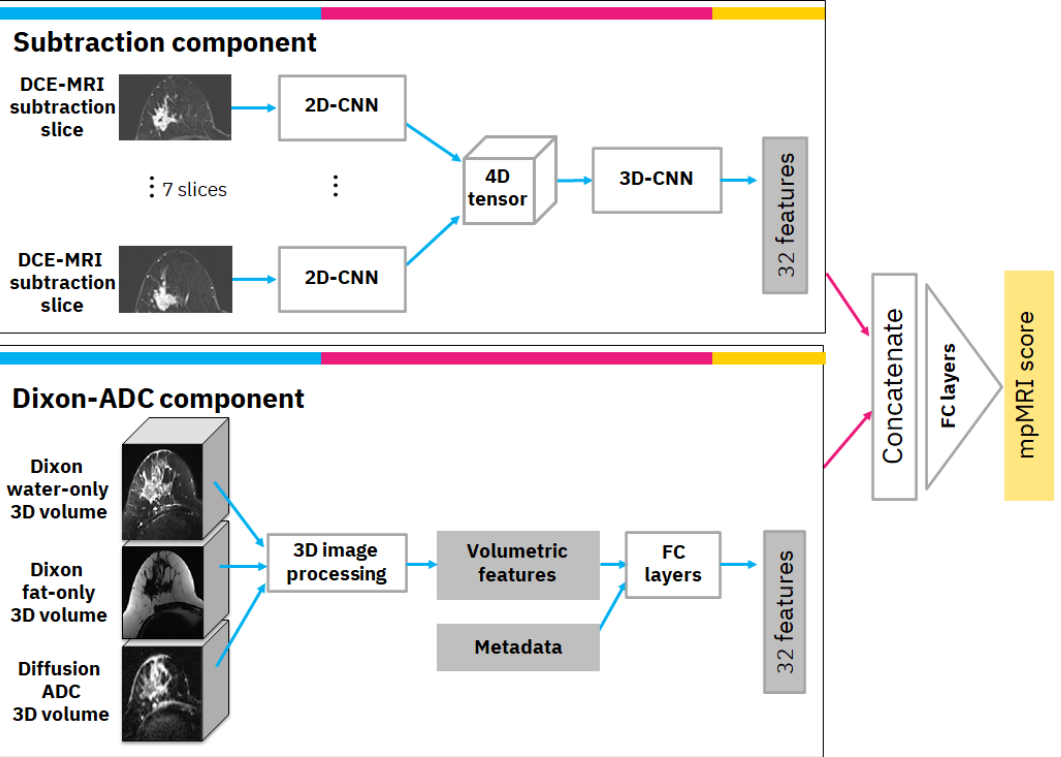
Figure 2. Multiparametric MRI model architecture. (Top) Subtraction component in which seven adjacent MRI slices (three pre-significant, significant, three post-significant) form the input to seven 2D-CNNs that have the same weights. The features are aggregated into a 3D-CNN followed by an average global pooling layer. (Bottom) Dixon-ADC component in which three 3D MRI volumes form the input to volumetric 3D image processing that generates volumetric features. The features from the two components are concatenated and transformed into the output score.